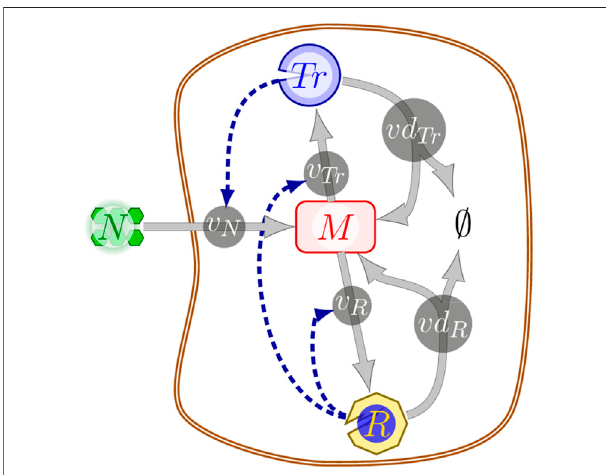
FIGURE 1 | A schematic illustration of the coarse-grained self-replicator model; solid lines represent biochemical reactions between the nodes (biochemical compounds), dashed dark-blue lines indicate that a reaction is catalyzed by the respective compound. Abbreviations: N , external nutrient; M , metabolic precursor/storage; Tr , transporter; R : ribosome; v N , nutrient uptake reaction; v R , ribosome production reaction; vd R , ribosome degradation reaction; v Tr , transporter production reactions; vd Tr , transporter degradation